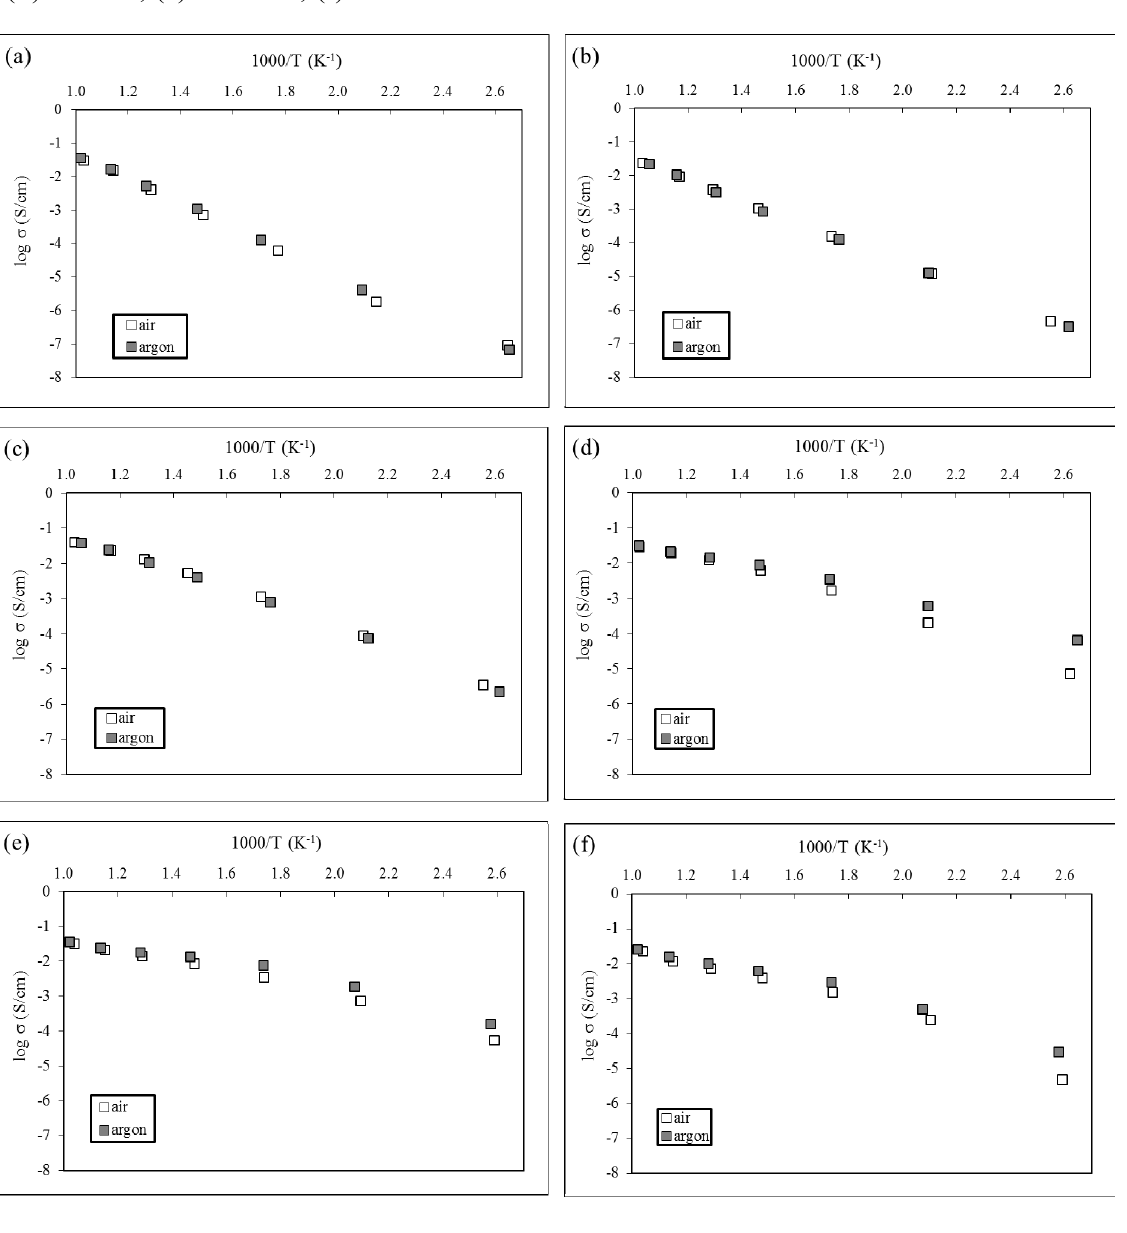
Figure 6. Arrhenius plots in air and argon of samples: ( a ) H; ( b ) 3% BA; ( c ) 4% BA; ( d ) 5% BA; ( e ) 10% BA; ( f ) 14%